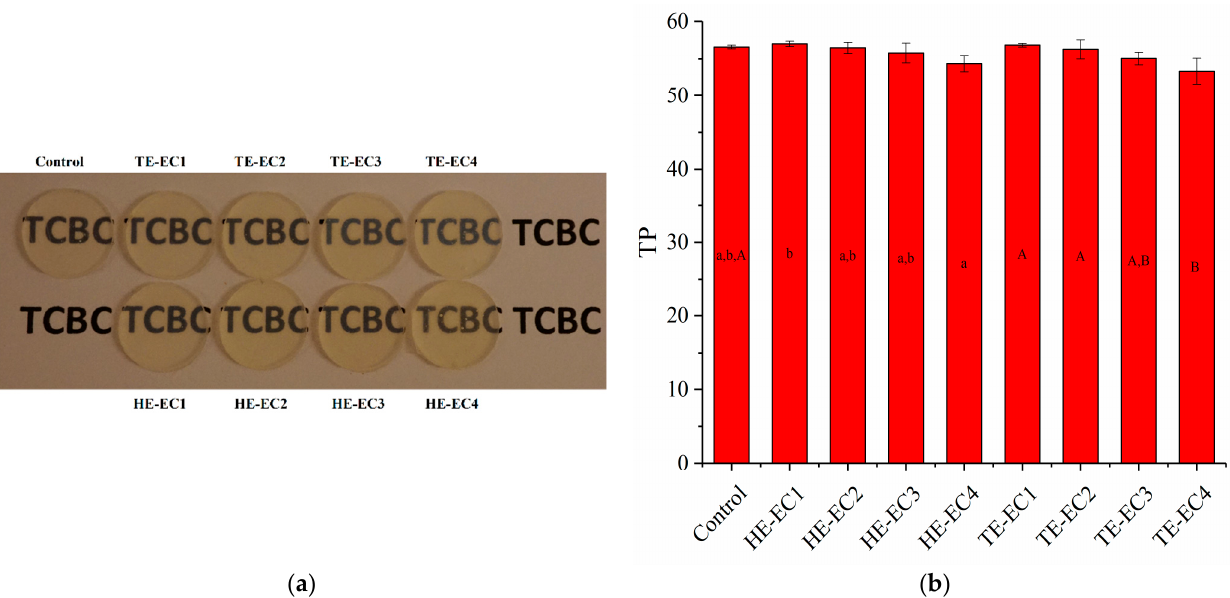
Figure 5. ( a ) Visual image of 2-mm thick composite resin specimens placed over a black letters line. ( b ) Translucency parameter mean values (TP) of experimental composite resins. The same lower letters indicated that there is no significant difference in TP between experimental composite resins with different weight fractions of HE-Phene in the resin matrix. The same upper letters indicated that there is no significant difference in TP between experimental composite resins with different weight fractions of TE-Phene in the resin matrix.